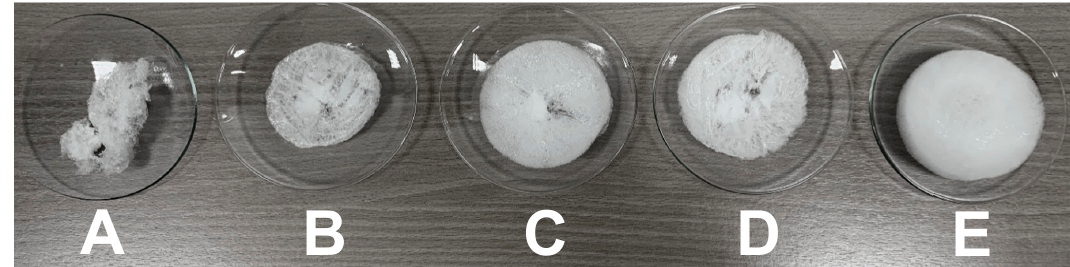
Figure 12. Freeze-dried samples of P1 ( A ), P2 ( B ), P3 ( C ), P4 ( D ), P5 ( E ) polymers.